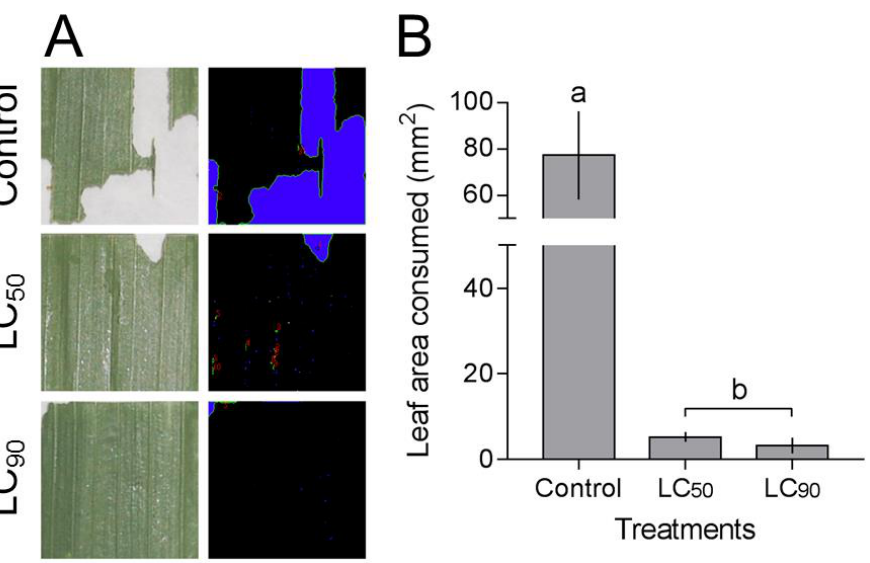
Figure 4. Anti-feeding effect caused by deltamethrin on Spodoptera frugiperda caterpillar. ( A ) Leaf section (20 × 20 mm) treated with distilled water and insecticide submitted to color binarization (black and blue) with identification and quantification of area consumed. ( B ) Leaf area consumed by S. frugiperda exposed to deltamethrin (control, LC 50 , and LC 90 estimated values). Treatments (mean ± SEM) differ at p < 0.05 (Tukey’s mean separation test) .